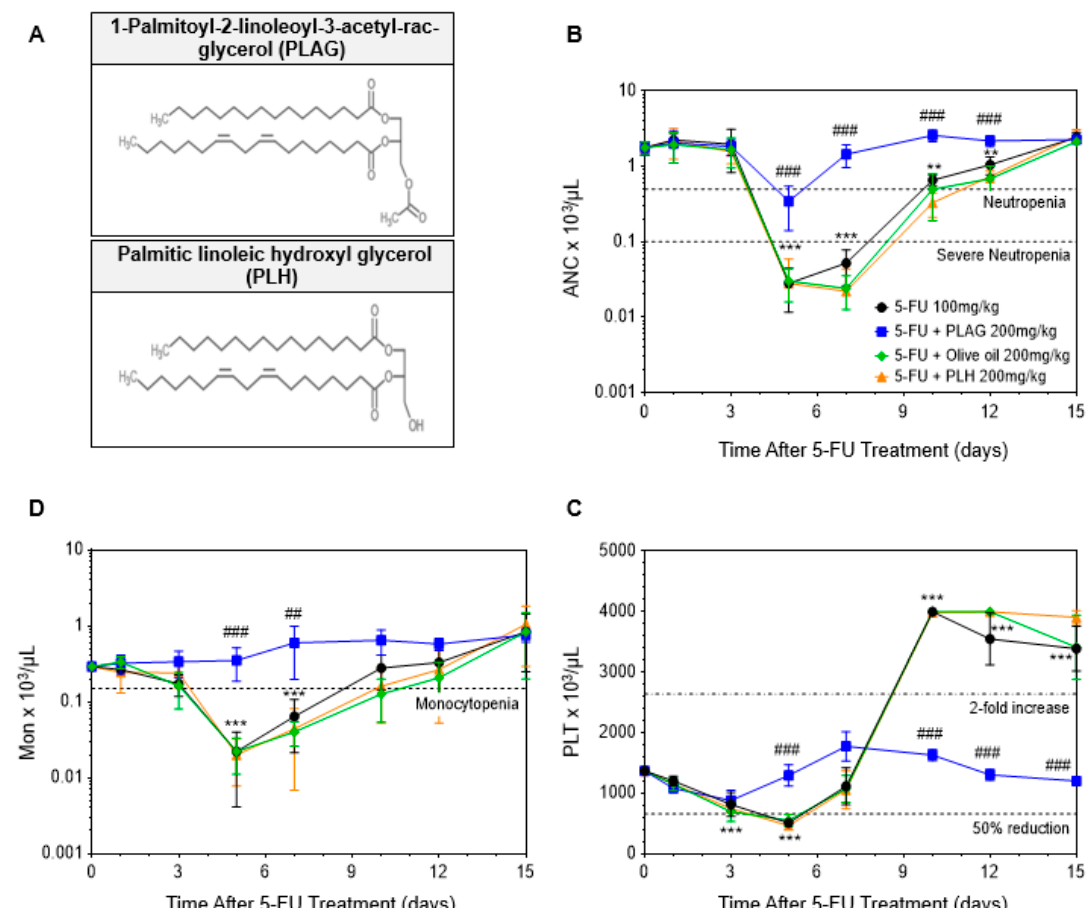
Figure 6. Effect of PLAG, olive oil, and PLH in 5-FU-induced hematological toxicity. Mice ( n = 5 males per group) were intraperitoneally injected to 100 mg / kg of 5-FU, immediately followed by oral administration of 200 mg / kg of PLAG, olive oil, or PLH, continuing daily until day 15. ( A ) The chemical structure of PLAG and PLH. The effect of PLAG, olive oil, or PLH administration on the kinetics of ( B ) ANC, ( C ) monocytes, and ( D ) platelets after 5-FU injection. The CBC data are representative of three independent experiments with five mice per group. * indicates negative control vs. 5-FU and # indicates 5-FU vs. 5-FU + PLAG-treated groups. * / # p < 0.05, ** / ## p < 0.01, *** / ### p < 0.001. ns, not significant.